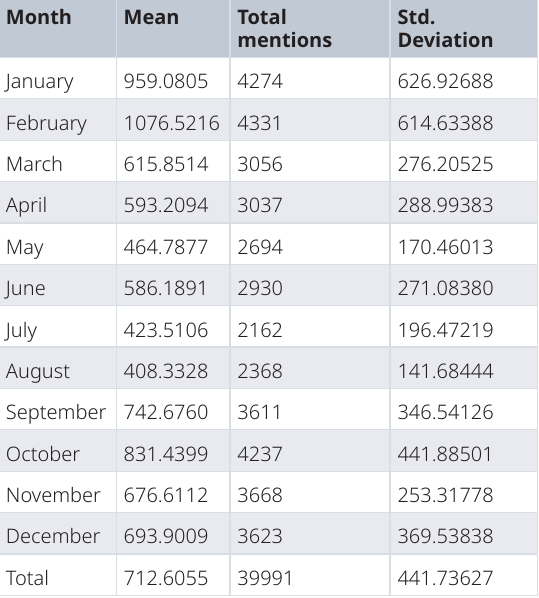
Table 1. Average US mentions of influenza-related articles each month in the years 2012 to